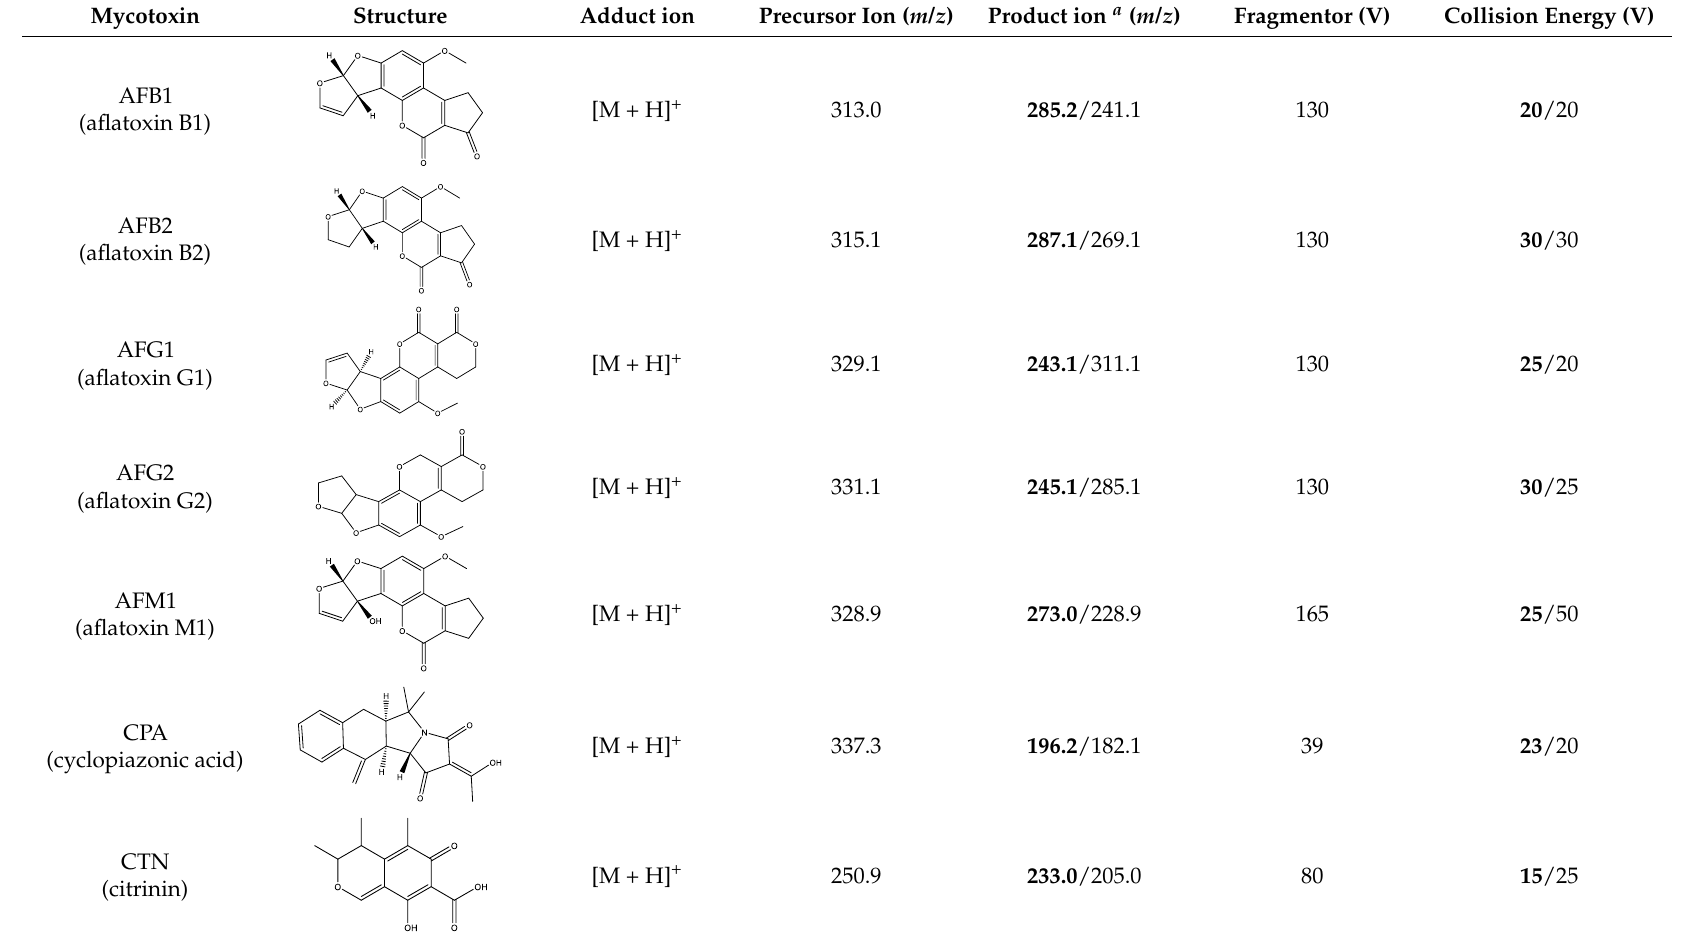
Table 1. MS/MS acquisition parameters for mycotoxins.